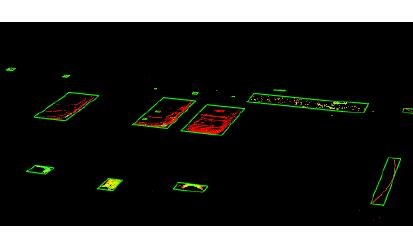
Figure 1(c). Data after extracted